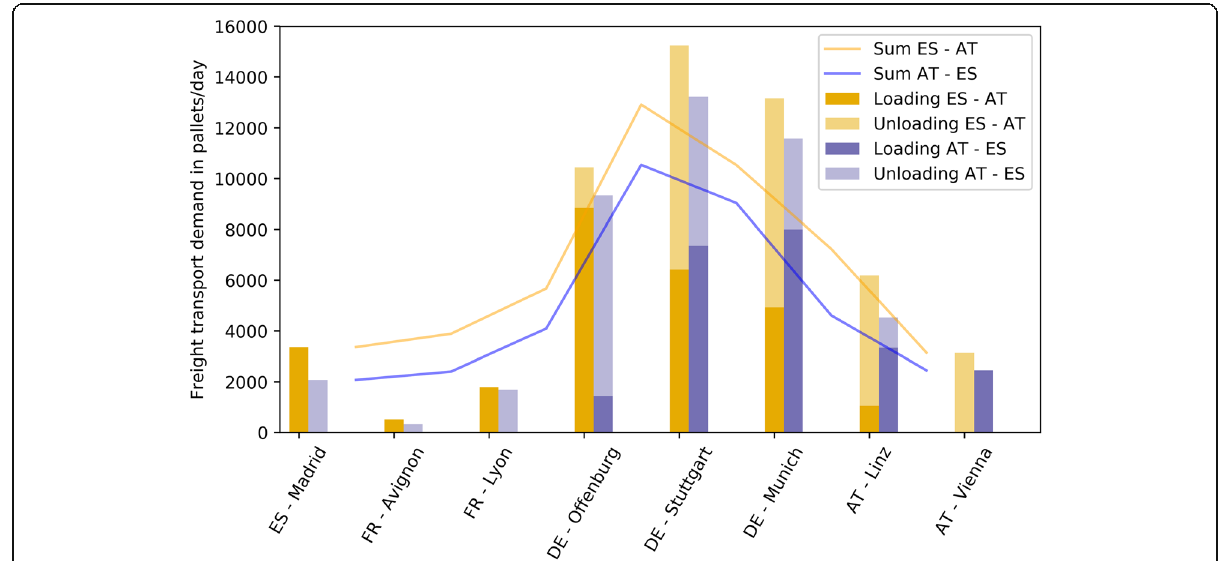
Fig. 2 Transport demand of LDHV goods on the transport corridor ES - AT and vice versa